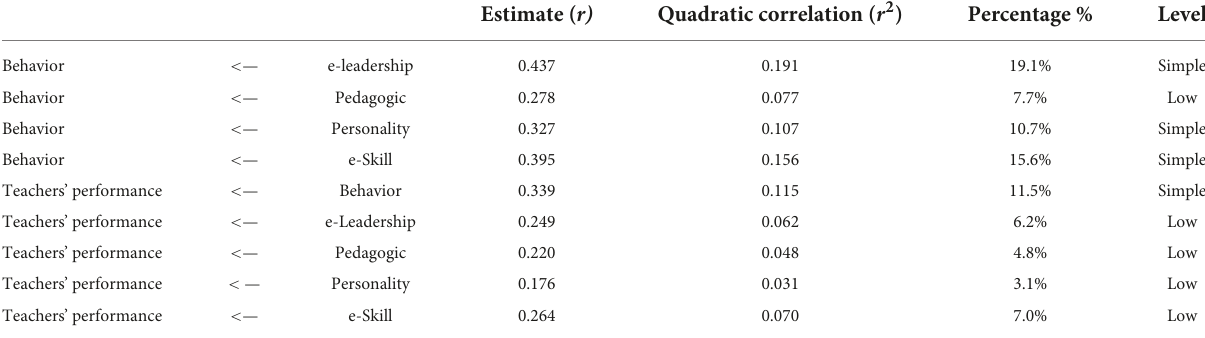
TABLE 14 Correlation of the independent variable to the dependent